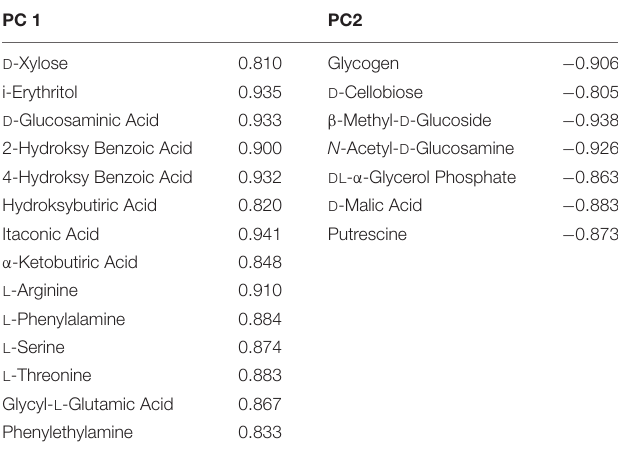
TABLE 1 | Carbon substrates utilized by microorganisms in Biolog EcoPlate TM, significantly correlated to PC1 and PC2 ( R >